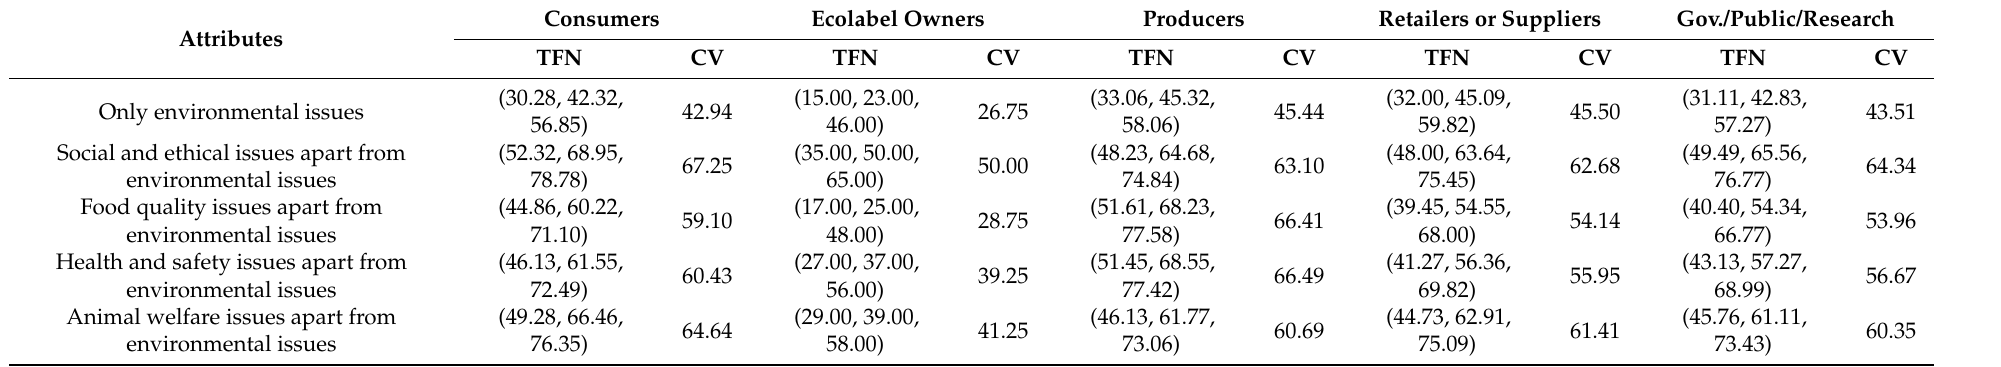
Table 5. TFNs and crisp values. Stakeholders’ segments of